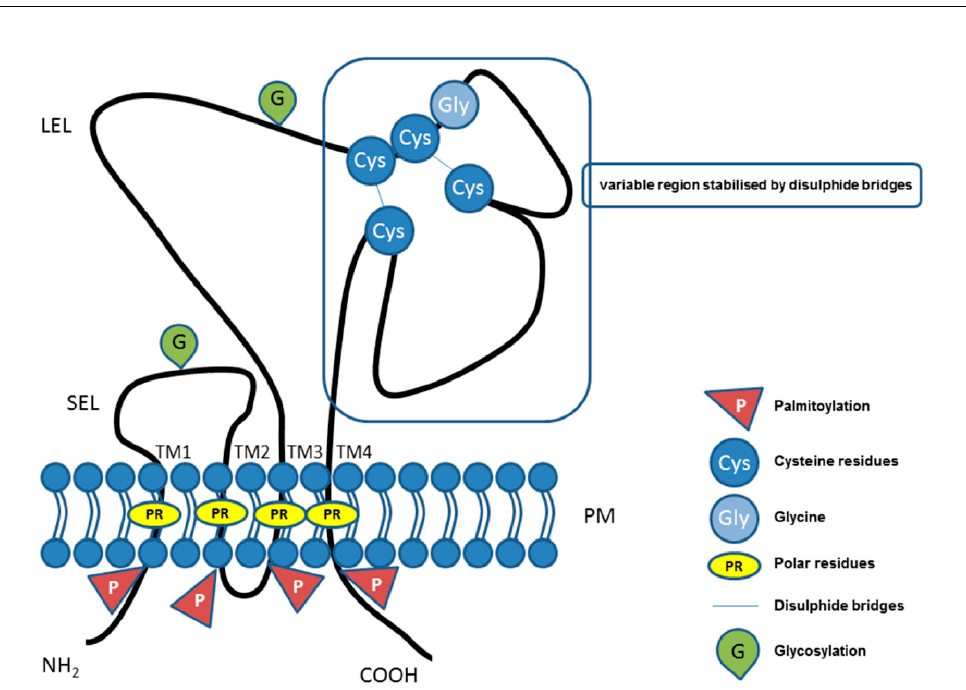
Figure 2. Illustrative schema of tetraspanin structure. Tetraspanin proteins traverse the